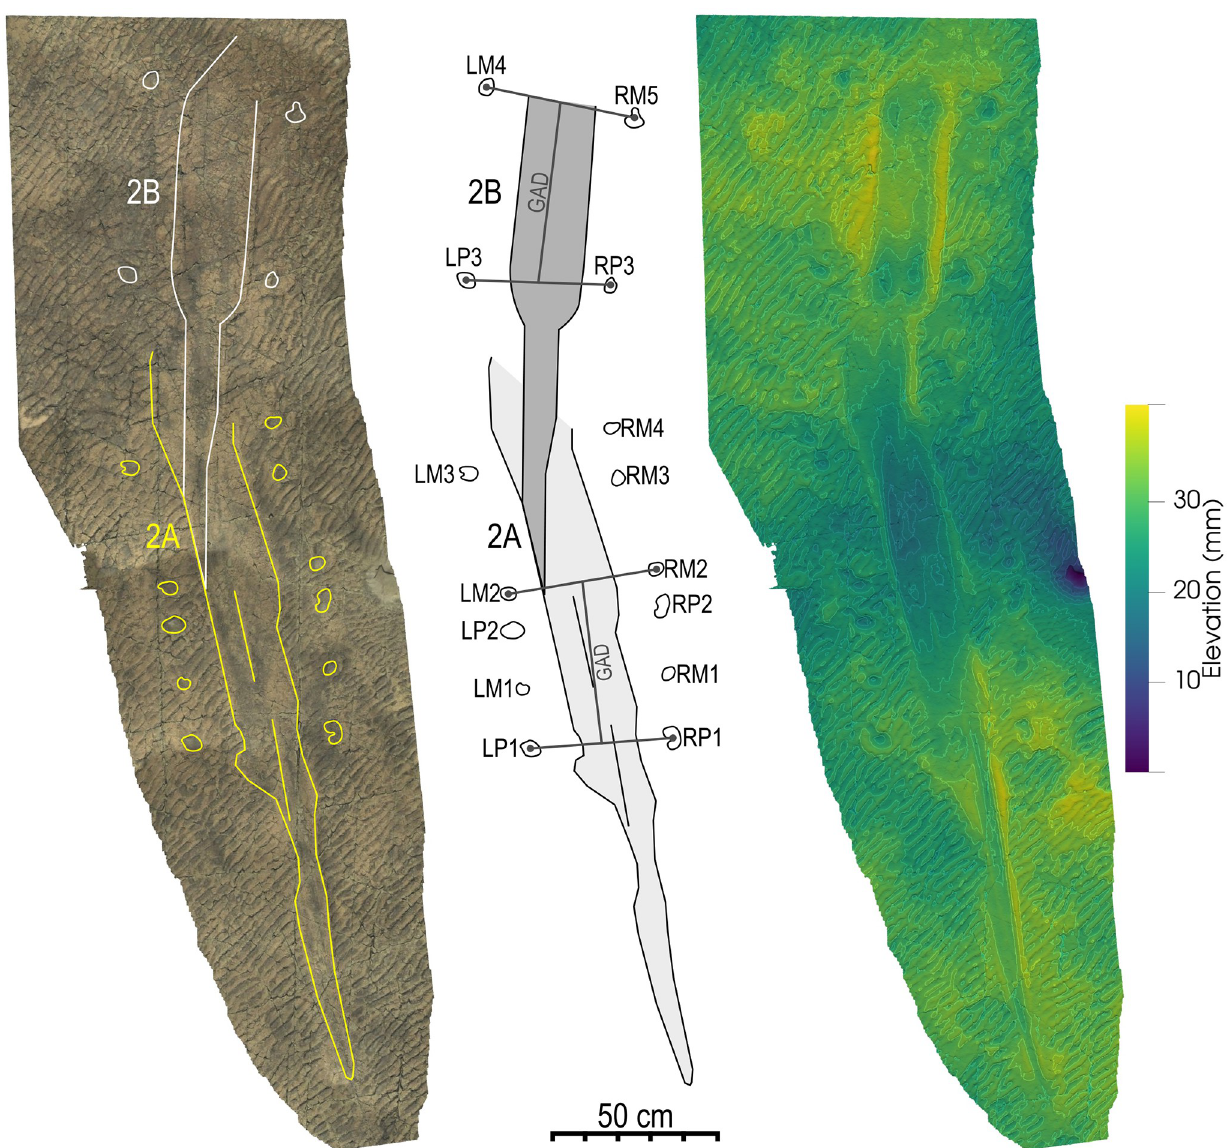
Fig 7. Details of Impression 2. Textured scan (Left) with the outline of the impressions [2A (yellow) and 2B (white)] and footprints compared to the false- colour depth model (Right). Depth scale is in mm.